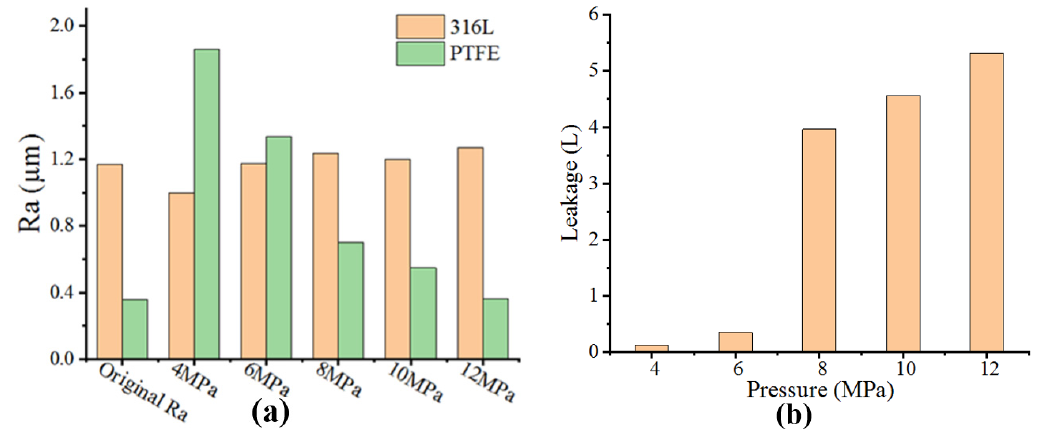
Figure 9. ( a ) The average roughness ( R a ) of 316L and PTFE after friction experiments; ( b ) the leakages of the friction pairs with different lubrication pressures.